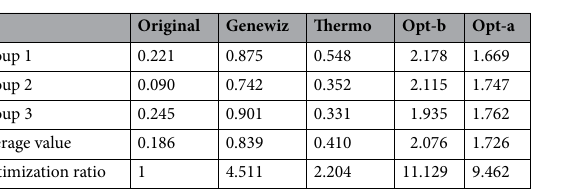
Figure 3. Comparison of protein expression levels for FALVAC-1 and PTP4A3. ( a ) shows the results of western blotting for FALVAC-1. ( b ) shows the results of western blotting for PTP4A3.